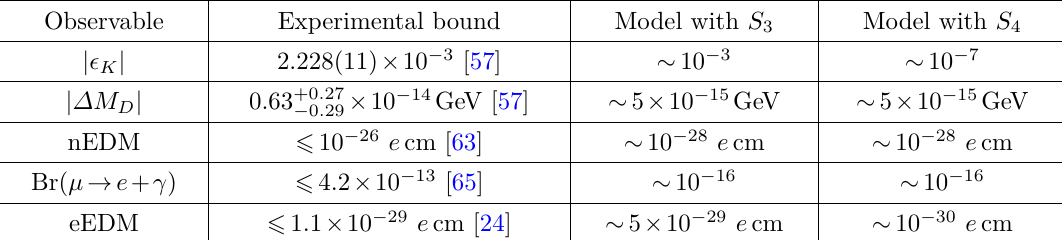
Table 1 . CP and flavor observables and their current experimental bounds. The estimation of the SUSY contribution to each observable in the models with U(1) H m q = M 3 = 5 TeV, m ‘ = M 1 , 2 = µ = 500 GeV and tan β = 50 . The typical mass scales of the e e trilinear soft SUSY breaking terms are taken as